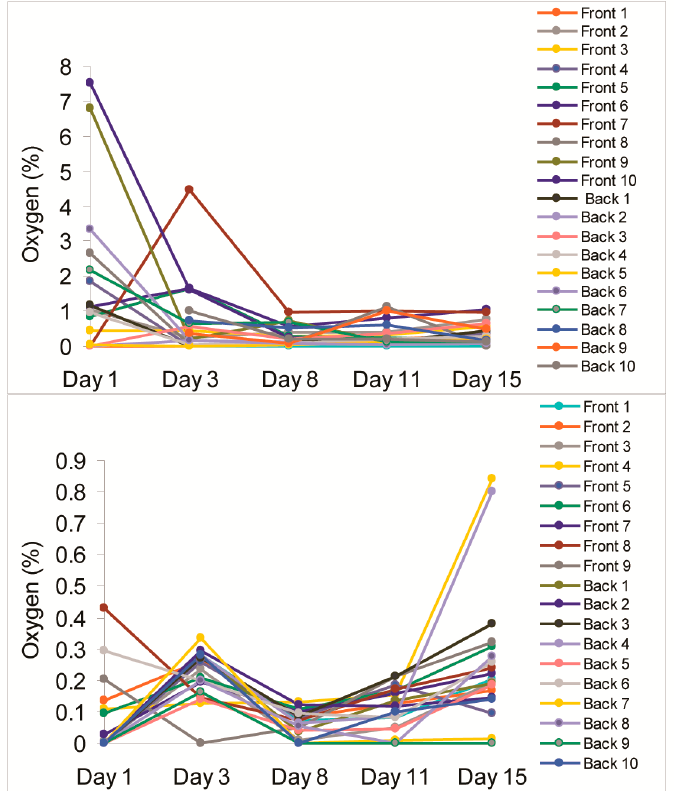
Figure 2. Mean O 2 readings obtained from sensor stickers placed in Bins 1 ( top ) and 3 ( bottom ) over a 15-day storage period.